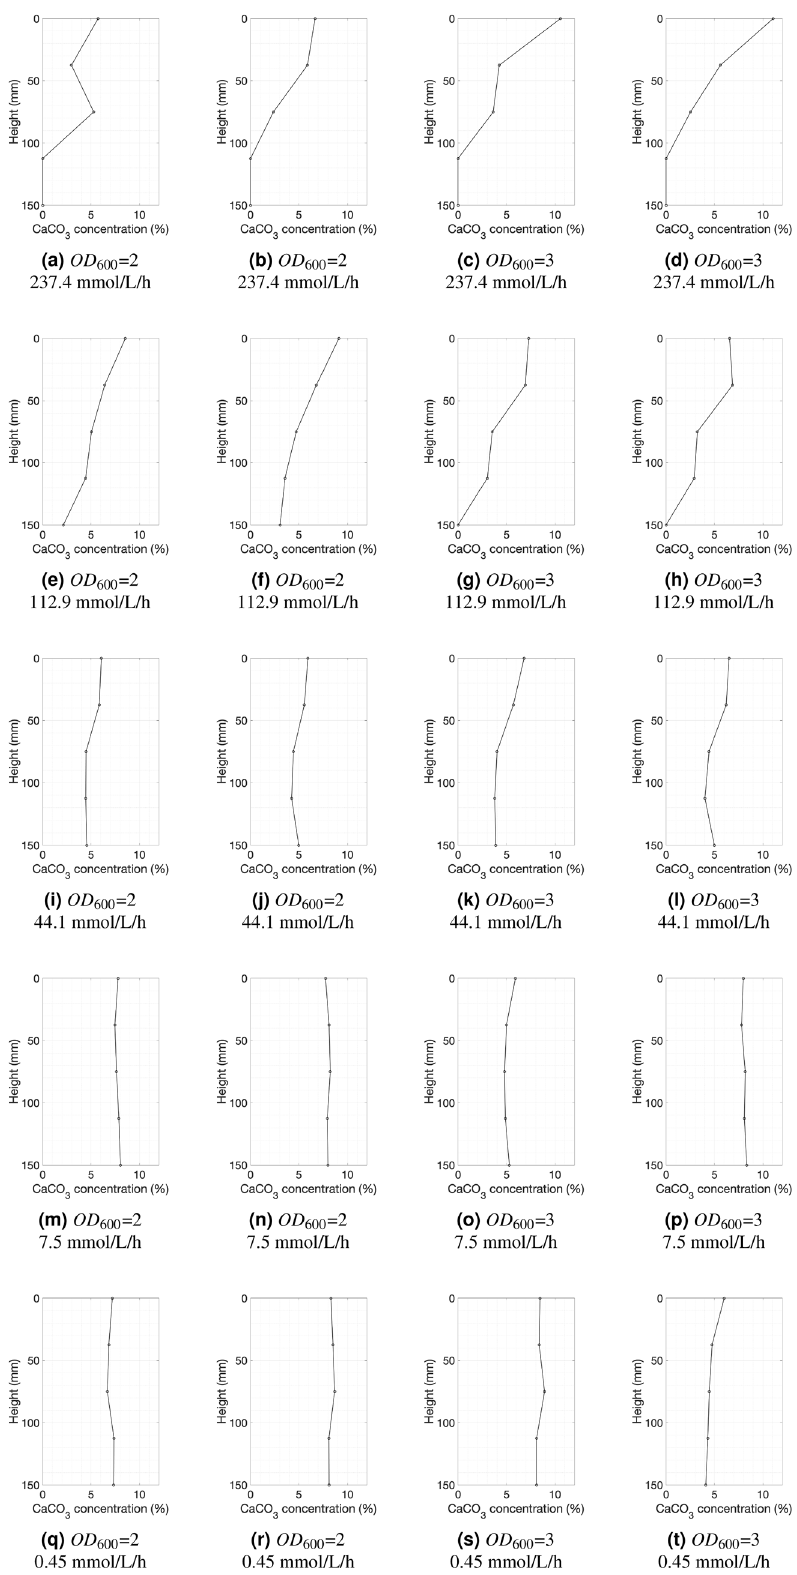
Figure 4. Calcium carbonate concentration profiles: each row reports results for a different urease activity with values decreasing from the largest activity at the top to the smallest at the bottom (237.4, 112.9, 44.1, 7.5 and, 0.45 mmol/L/h respectively, measured following the standard protocol 1 ); the first two profiles in each row are for samples generated with OD 600 = 2, whilst the last two profiles of each row are for samples generated with OD 600 = 3. The calcium carbonate concentration of each specimen was measured at 5 points along its height and the injection was from top to